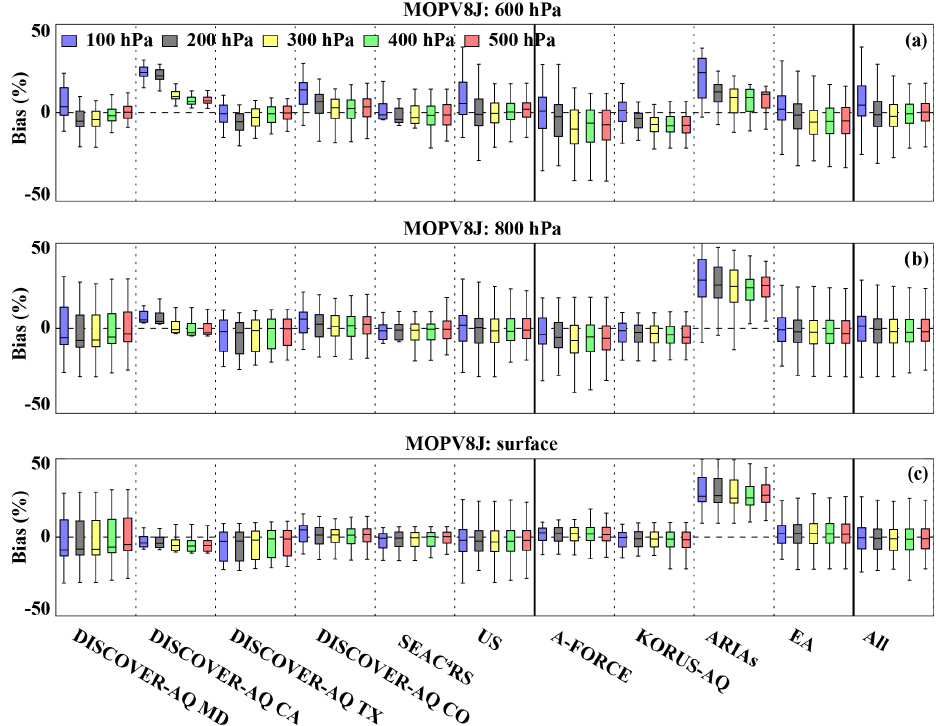
Figure 8. Sensitivity to P interp . Biases (%) using 100hPa (blue), 200hPa (gray), 300hPa (yellow), 400hPa (green), and 500hPa (red) as P interp at 600hPa layer (a) , 800hPa layer (b) , and the surface layer (c) are shown by box plot (with medians represented by middle bars, interquartile ranges between 25th and 75th percentiles represented by boxes, and the most extreme data points not considered outliers represented by whiskers). The biases are calculated against all (both urban and non-urban) in situ profiles listed in Table 1. The “200hPa” values (gray bars) in this figure are the same as yellow bars (for all data) in Fig. 6. See the caption of Fig. 6 for the definition of